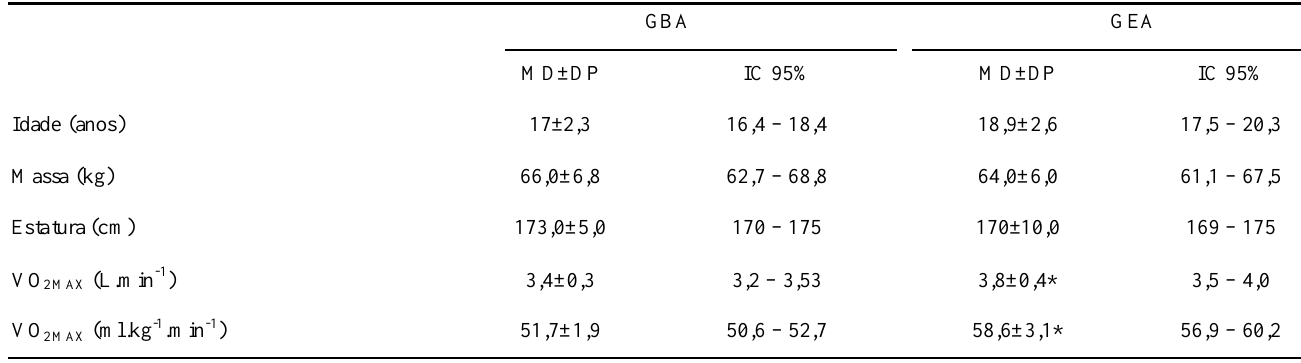
* Diferença significativa entre os dois grupos (p<0,05).